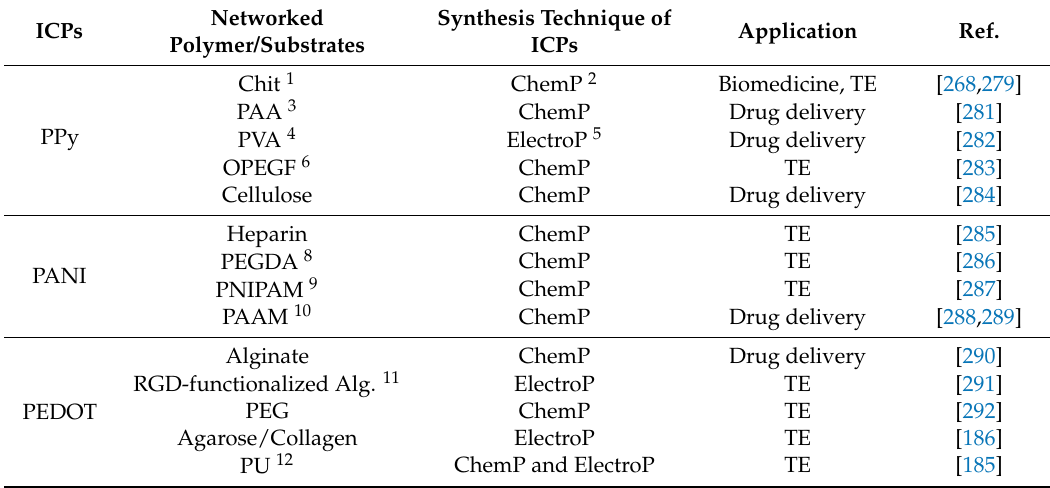
Table 4. ICPs with networked polymers/substrates used for biological